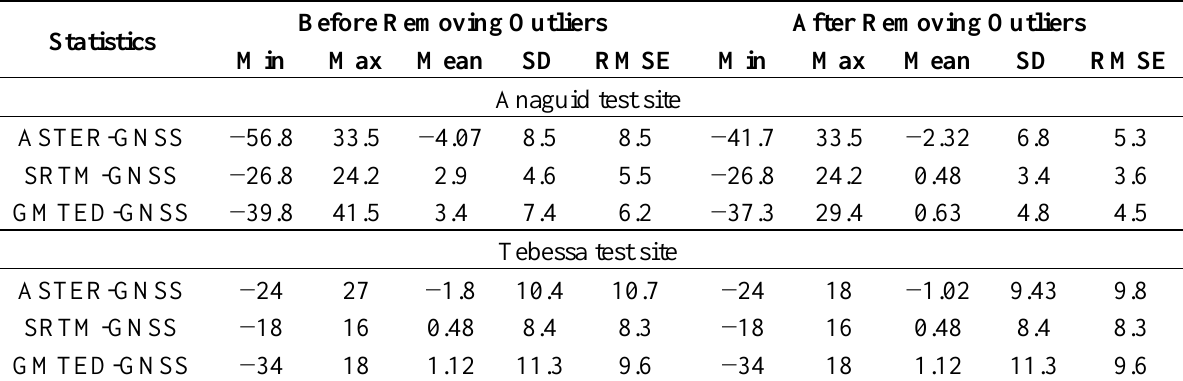
Table 2. Difference statistics of the study sites (Units in